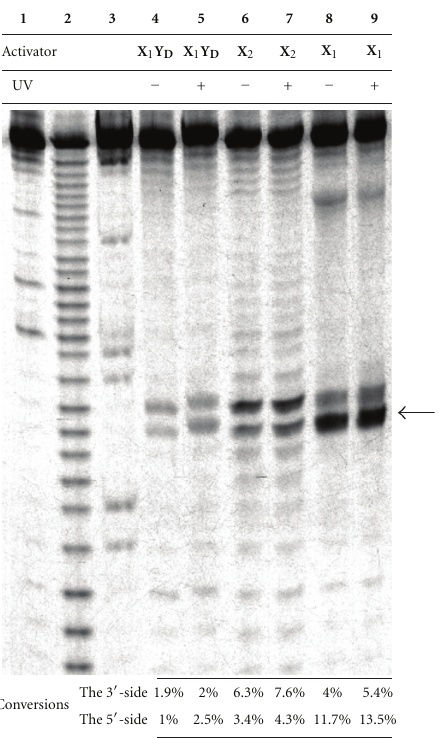
Figure 2: A denaturing 20% PAGE pattern for site-selective scission of 1 activated by 2 or ( 4 + 5 ) in the presence of Lu(III) with or without UV irradiation. Lane 1, control in a bu ff er solution; lane 2, treatment with Lu(III) alone; lane 3, RNase T1 digestion; lane 4, 2 and Lu(III) without UV irradiation; lane 5, 2 and Lu(III) with UV irradiation; lane 6, 4 , 5, and Lu(III) without UV irradiation; lane 7, 4 , 5, and Lu(III) with UV irradiation; lane 8, 3 and Lu(III) without UV irradiation; lane 9, 3 and Lu(III) with UV irradiation. The 5 (cid:2) - side cleavage of U-19 is indicated by the arrow. Conversions of each scission are presented in the bottom. Reaction conditions; [RNA] = 5 μ M, [DNA] = 10 μ M, [LuCl 3 ] = 100 μ M, [Tris] = 10mM, [NaCl] = 200mM, pH 7.5, 37 ◦ C, 4 h.